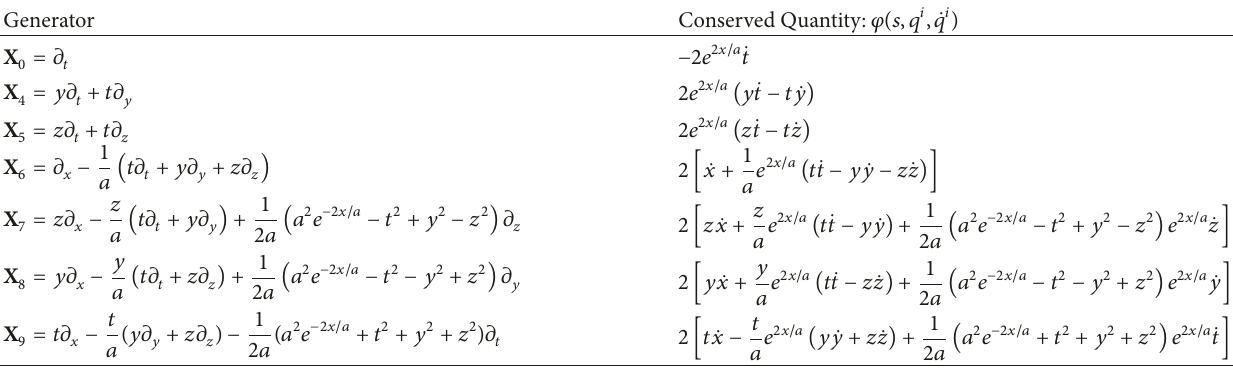
Table 5: Conserved quantities corresponding to each Noether